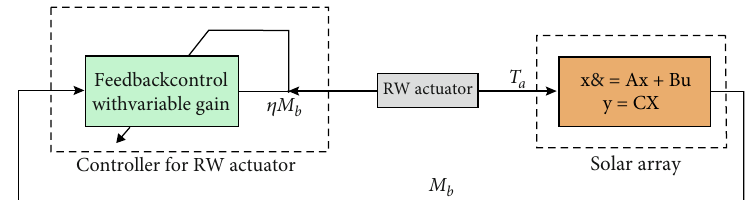
Figure 6: Diagram of the feedback control with variable gain.